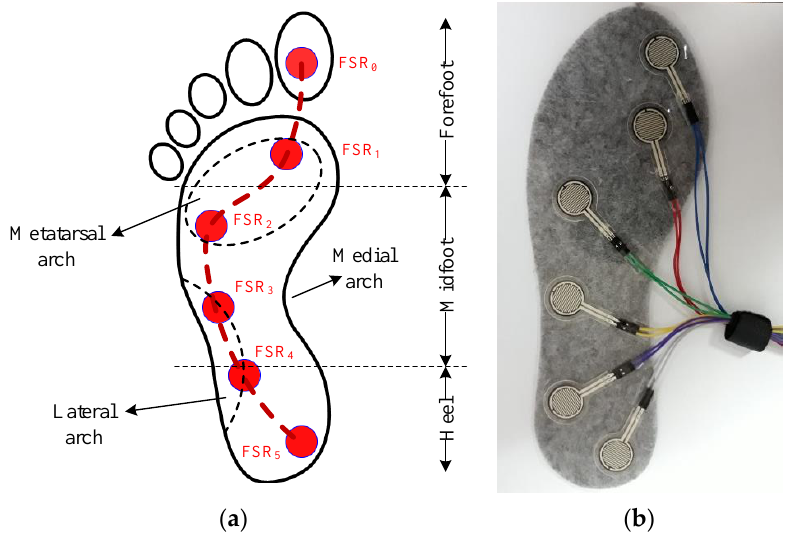
Figure 9. Proposed pressure sensor deployment along the COP progression line for plantar pressure assessment: ( a ) diagram, ( b ) practical realization.